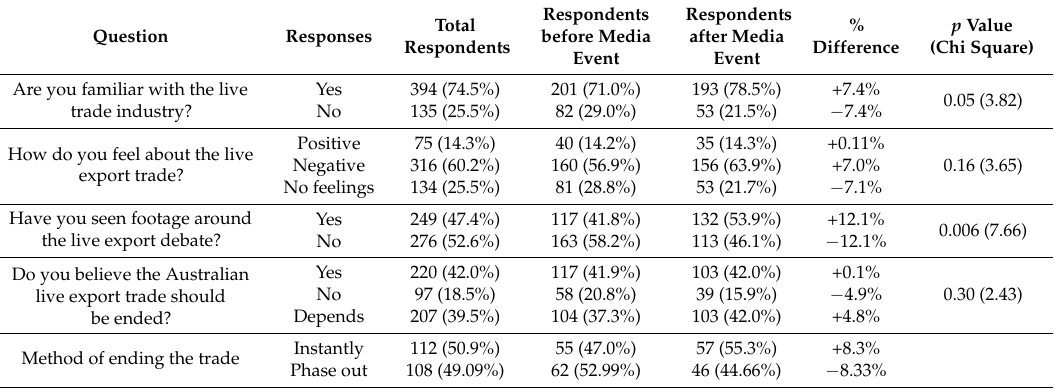
Table 2. Responses to questions about the live export trade in surveys conducted before and after a media event about live export *.